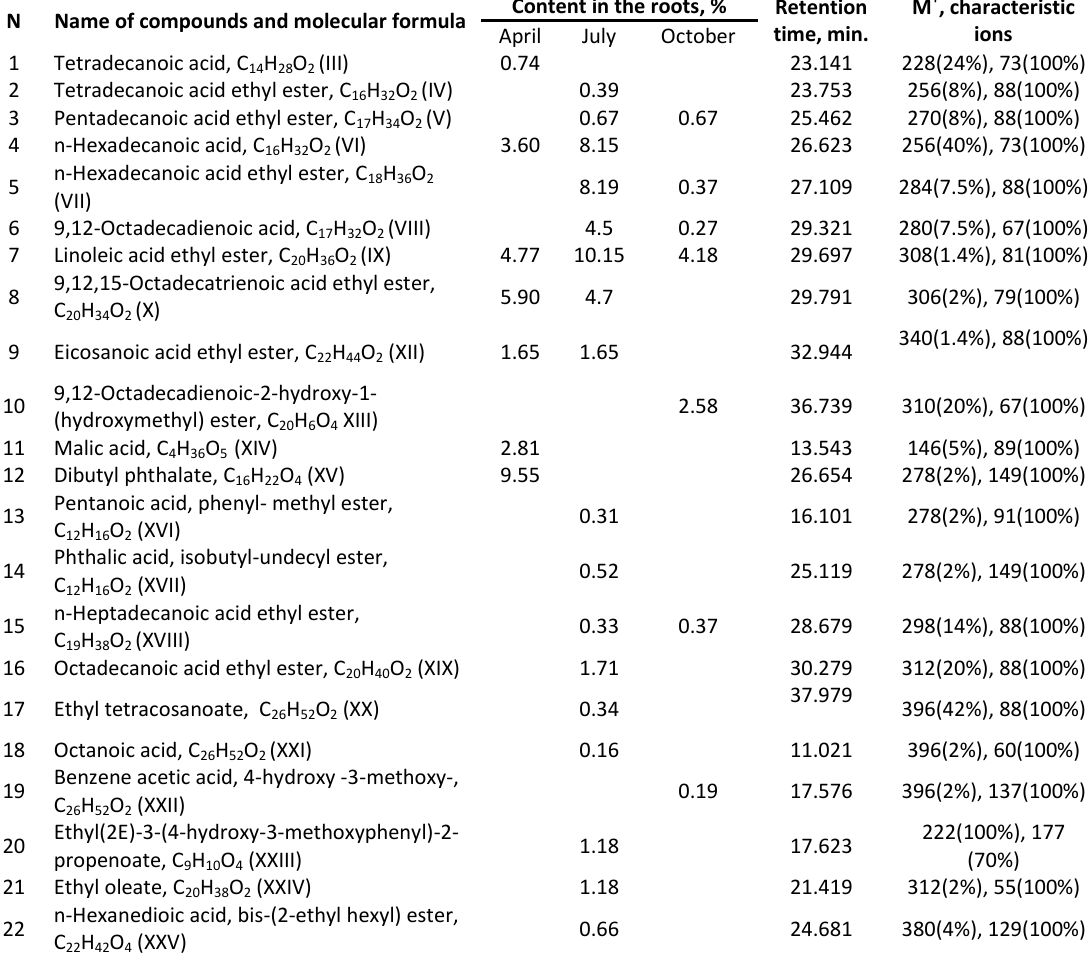
Table 2. Fatty acids and their esters of the chloroform fraction from roots of Cicuta virosa